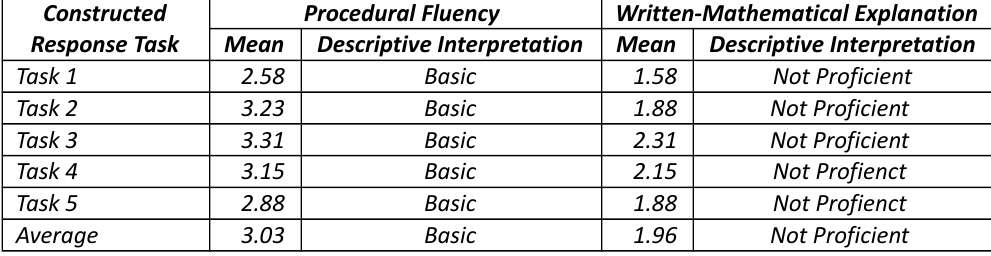
Table 1. The Students Level of Performance on Constructed Response Task in terms of Procedural Fluency and Written-Mathematical Explanation